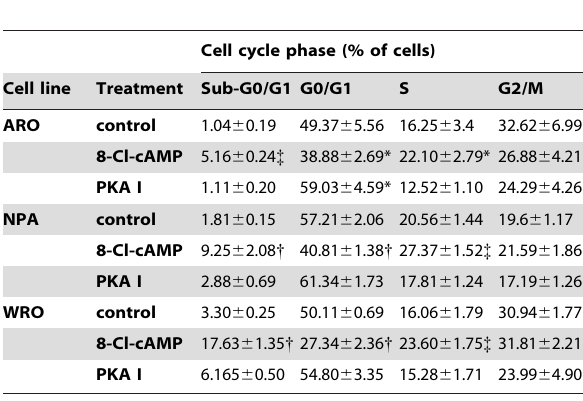
Table 1. Effects of 8-Cl-cAMP and the PKA I-selective analogs on cell cycle.